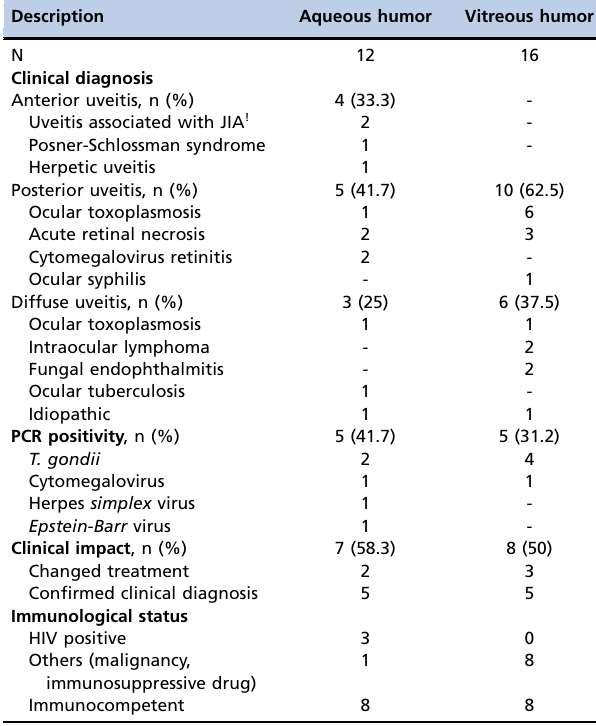
Table 1 - Clinical data and polymerase chain reaction (PCR) results of 28 samples of patients with uveitis included in the